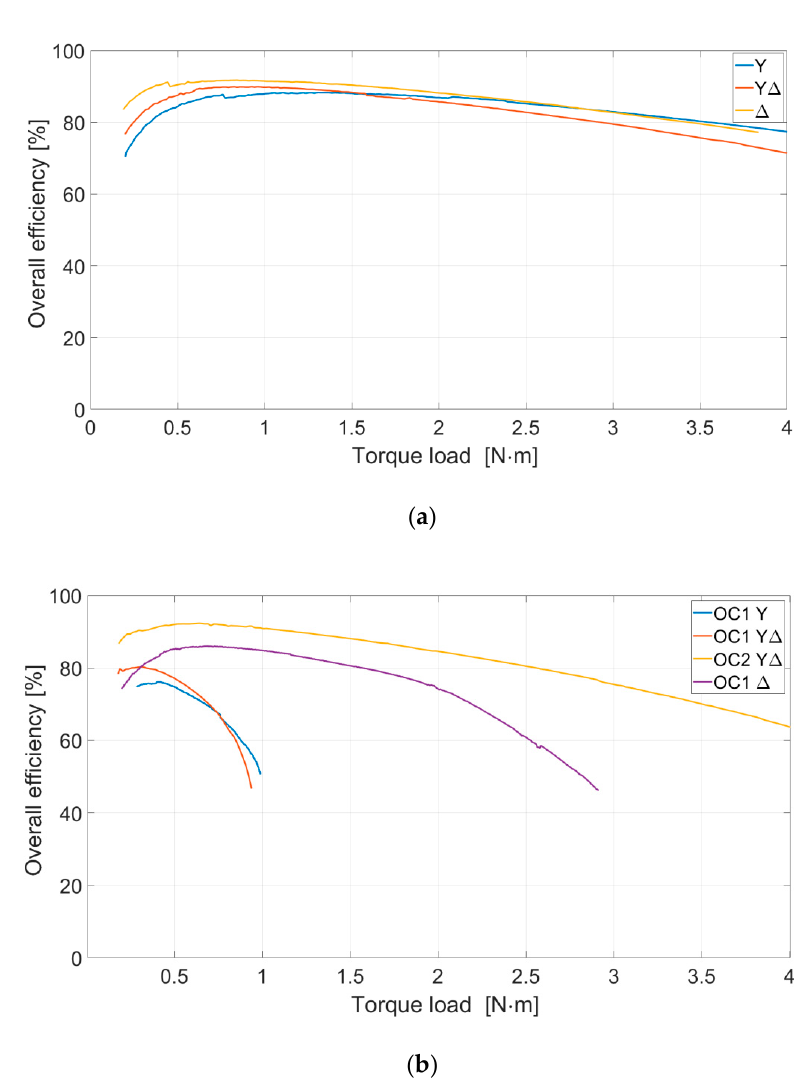
Figure 25. Overall efficiency vs. load torque for Y, Y Δ and Δ configurations: ( a ) healthy mode; ( b ) OC fault state.